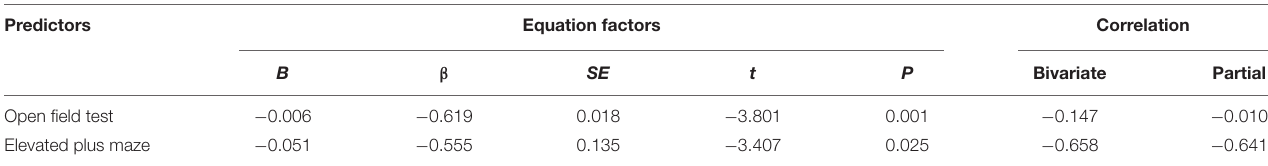
Predictors Equation factors Correlation B β SE t P Bivariate